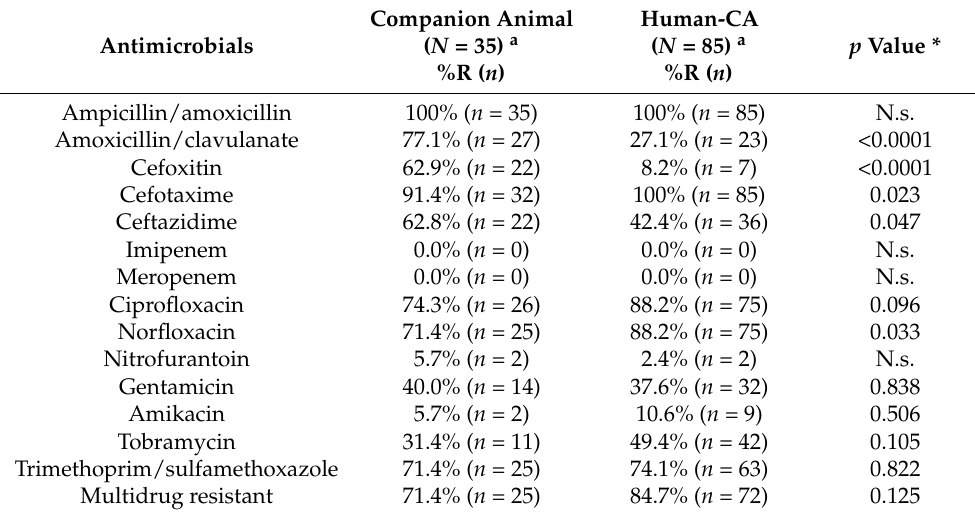
Table 1. Antimicrobial resistance of 3GC-resistant E. coli isolated from companion animals and humans with UTI.